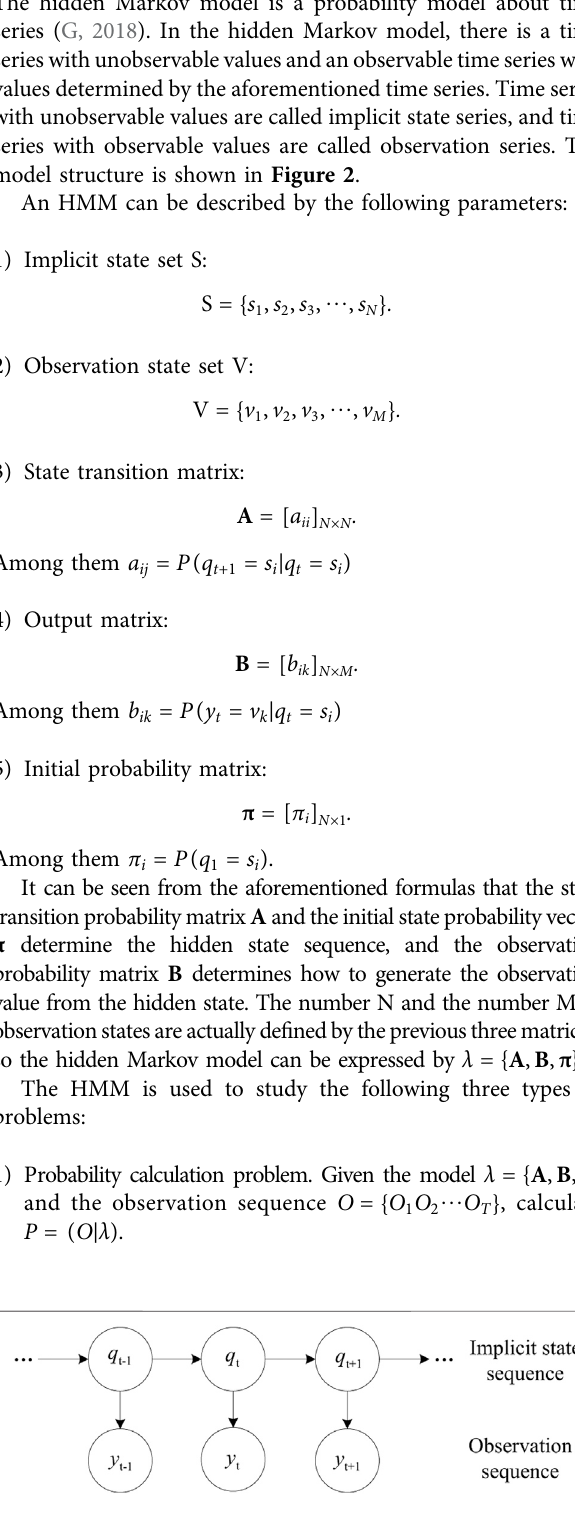
FIGURE 2 | Structure chart of hidden Markov